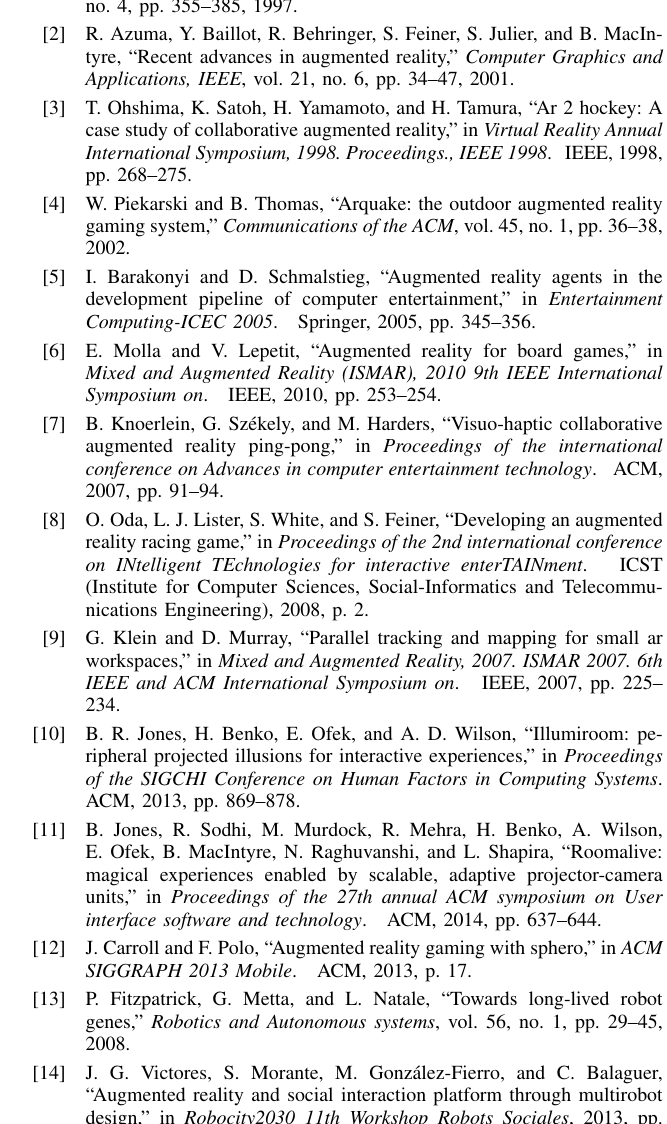
some way to stream video. It has also possible to extend the game by adding virtual elements such as weapons, HUDs, bonus,